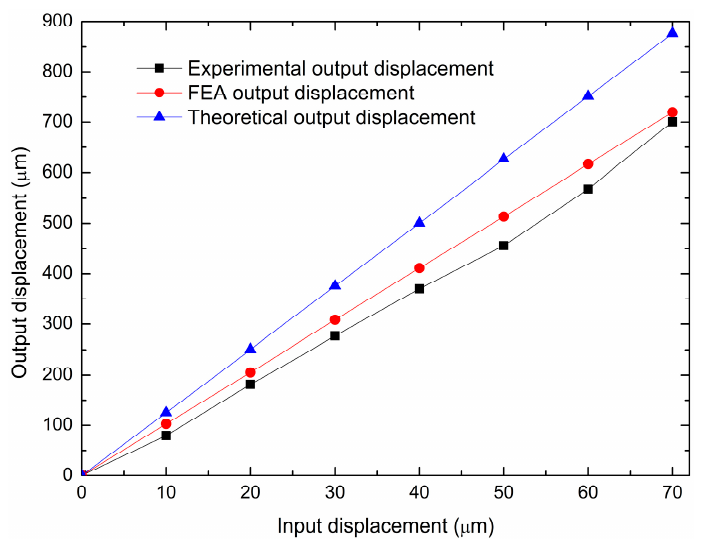
Figure 14. Comparison of the total amplification factor obtained experimentally, with the theoretical model and